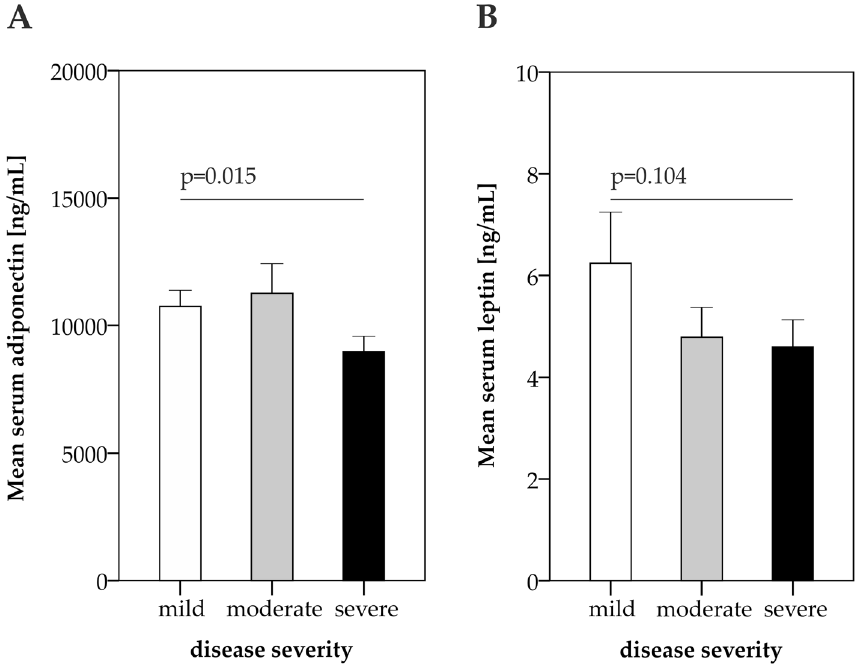
Figure 3. Adipocytokine concentrations at early post-acute follow-up are related to acute COVID-19 severity. Adiponectin ( A ) and leptin ( B ) serum concentrations at 60 days post-COVID-19 follow-up. Patient subgroups are shown according to the acute COVID-19 severity. Error bars depict one standard error. N mild = 34, N moderate = 38, N severe = 73. P -values were determined using the Kruskal–Wallis test.